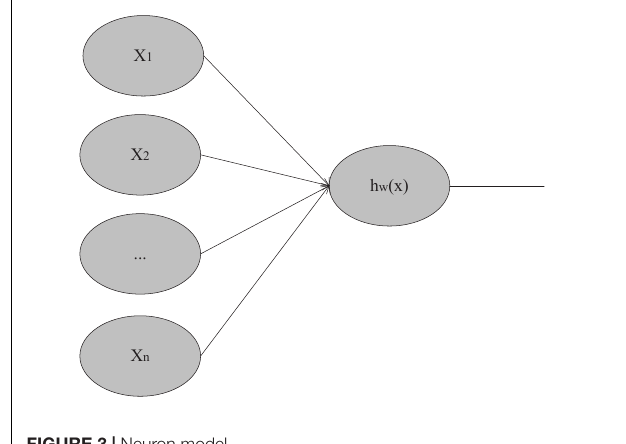
FIGURE 3 | Neuron model.